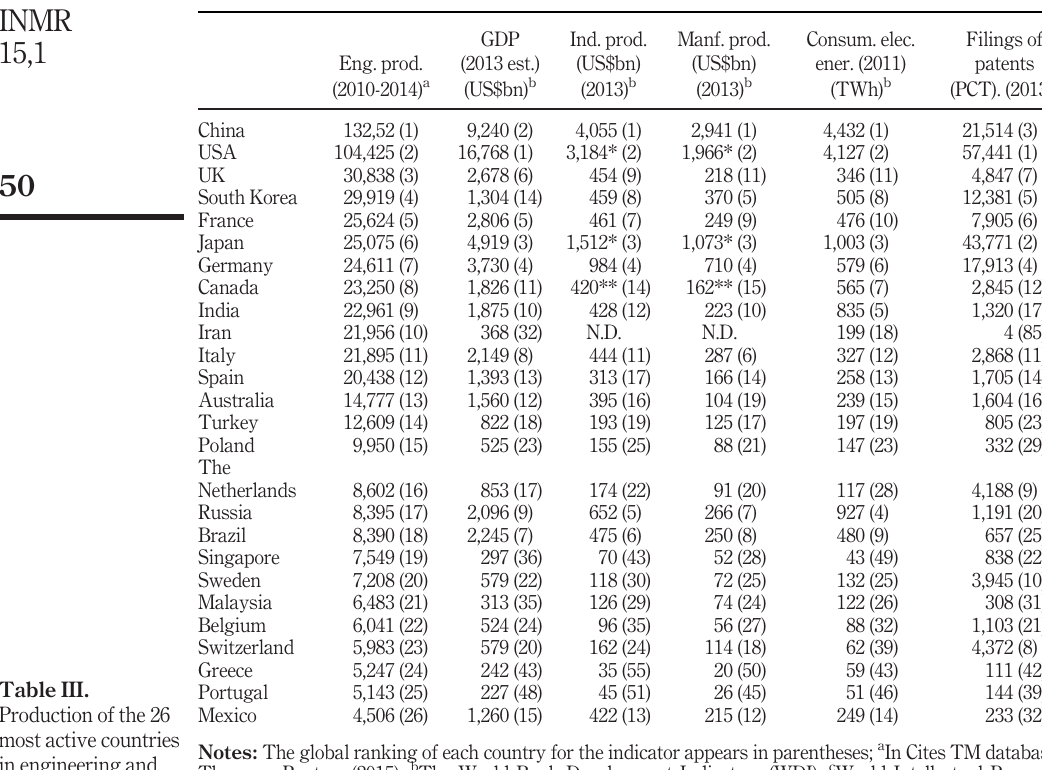
Table III. Production of the 26 most active countries in engineering and their economic